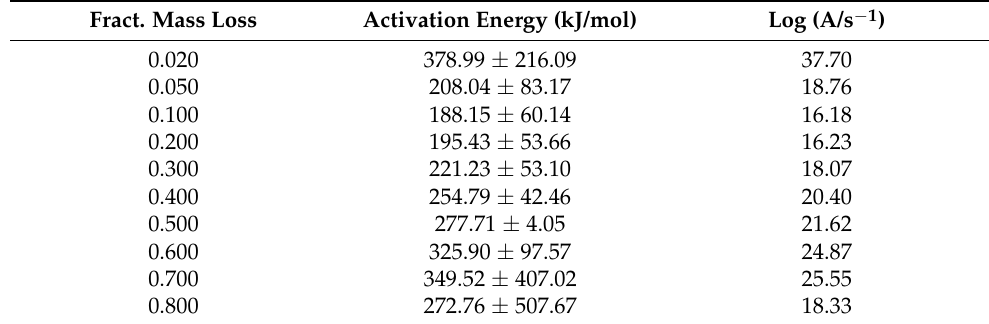
Table A2. Activation energy and pre-exponential coefficient as a function of the degree of reaction determined by the Friedman method for sewage